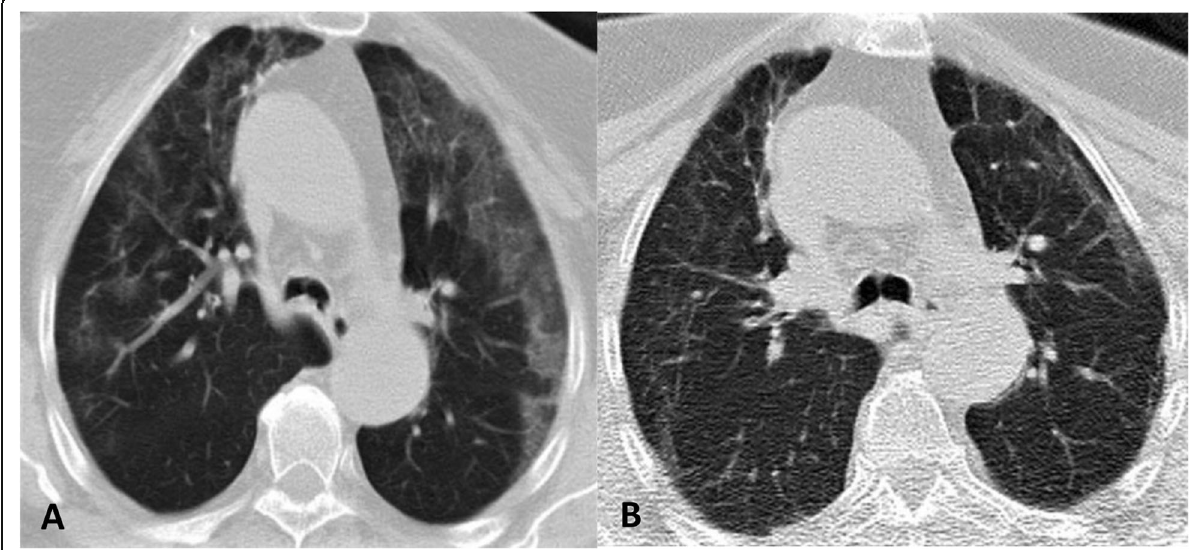
Fig. 4 A 55-year-old RT-PCR (+) female patient with fever, cough, and abdominal pain. a Initial CT image obtained shows bilateral peripherally located ground glass areas. b 2nd month follow-up CT image shows almost complete regression of ground glass opacities and shows newly developed fibrous